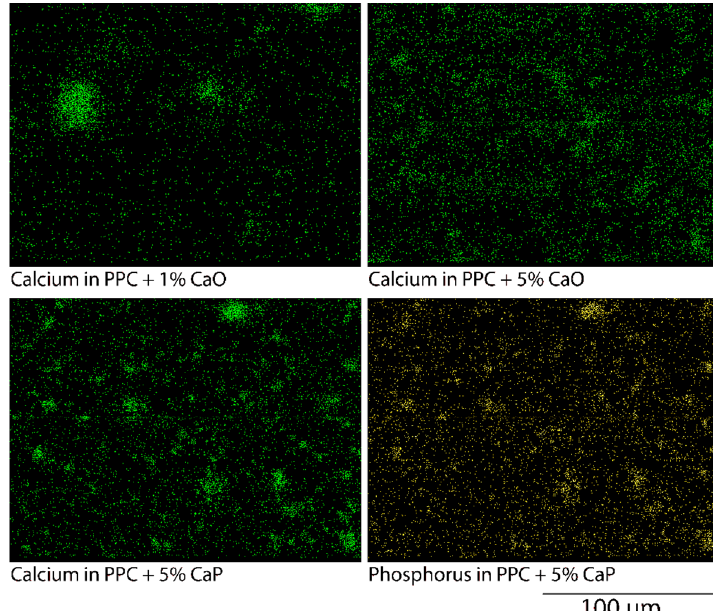
Figure 4. Elemental mapping of calcium and phosphorus on the different coated